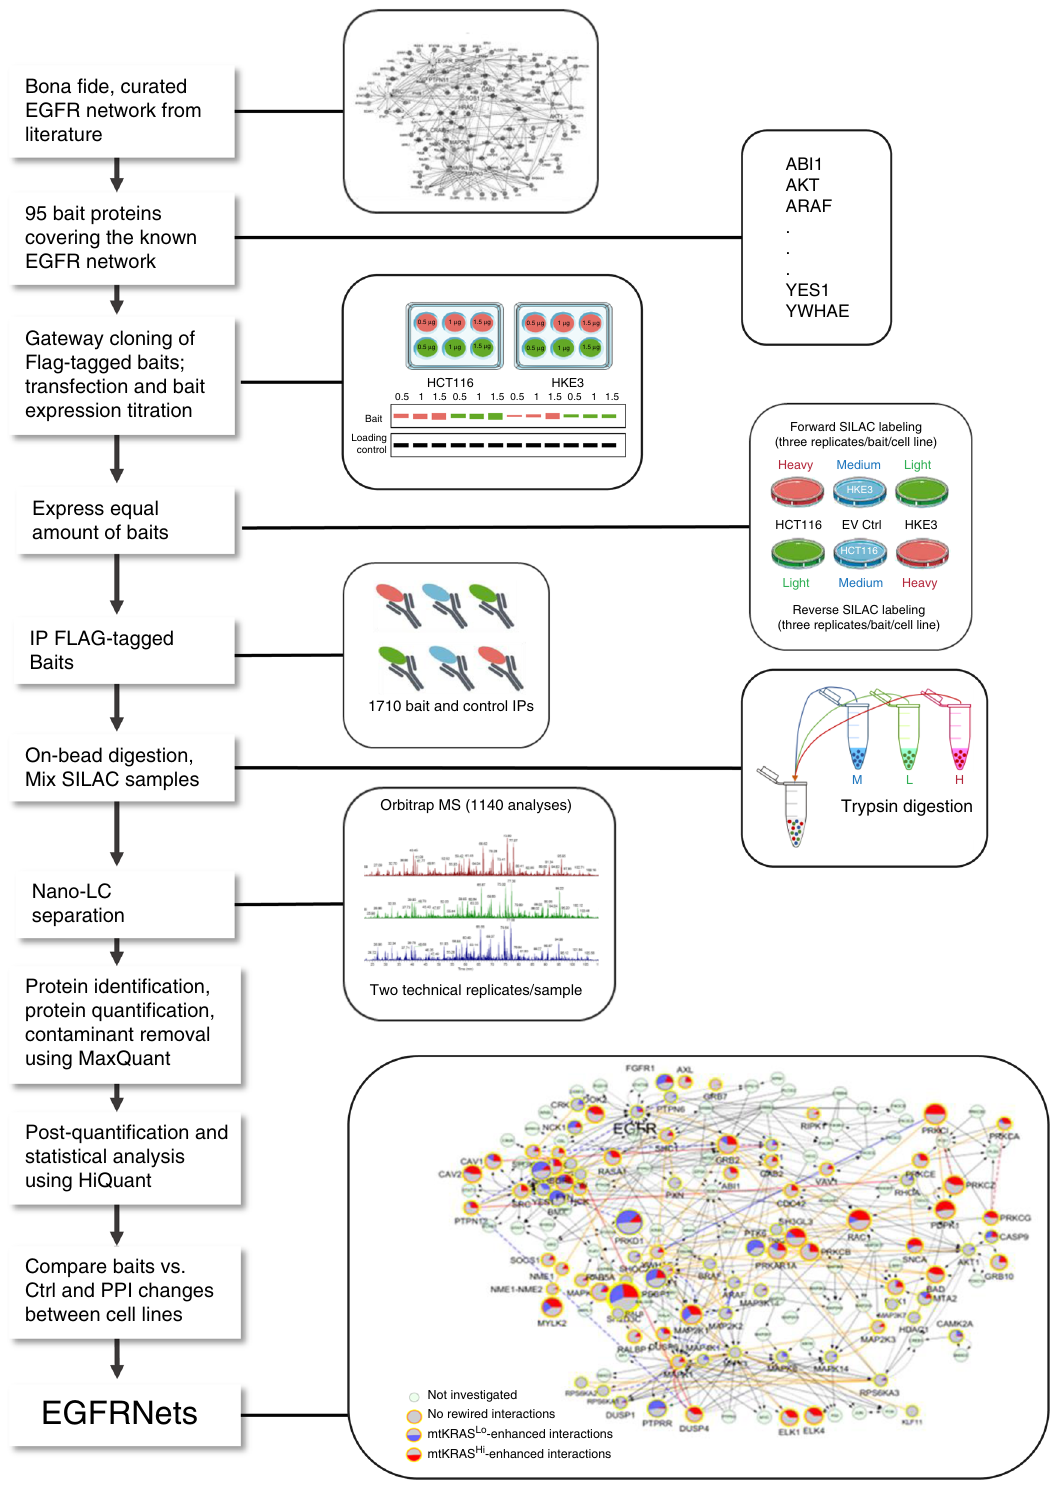
Fig. 1 Experimental and data analysis work fl ow for the comparative mapping of PPIs in the EGFR network. Baits were chosen based on the core EGFR network described by Kiel et al. 18 and additional manually curated literature information. Flag-tagged expression vectors were constructed using the Gateway cloning system and transfected into HCT116 (mtKRAS Hi ) and HKE3 (mtKRAS Lo ) cells. Careful titration of the transfected plasmids ensured similar protein expression in both cell lines grown in SILAC media as monitored by Western blotting. For MS experiments similar amounts of baits were expressed in SILAC labeled HCT116 and HKE3 cells and immunoprecipitated (IP) with anti-Flag antibodies. To assure robust quantitation the SILAC label was swapped, i.e. each bait was isolated from HCT116 and HKE3 cells grown in heavy or light medium, respectively. After trypsin digestion peptides were identi fi ed and quanti fi ed by orbitrap mass spectrometry. Raw data were analysed using MaxQuant 59 and further processed using HiQuant 19 implementing a stringent pipeline to retain only true interactors. Based on these data two quantitative protein – protein interaction networks, termed EGFRNet mtKRAS-Hi and EGFRNet mtKRAS-Lo , were reconstructed and are shown in a combined differential network representation. EV Ctrl, empty vector control